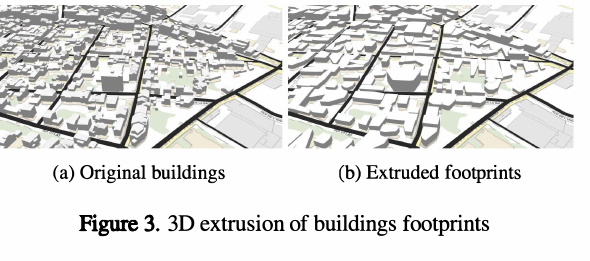
Figure 3. 3D extrusion of buildings footprints